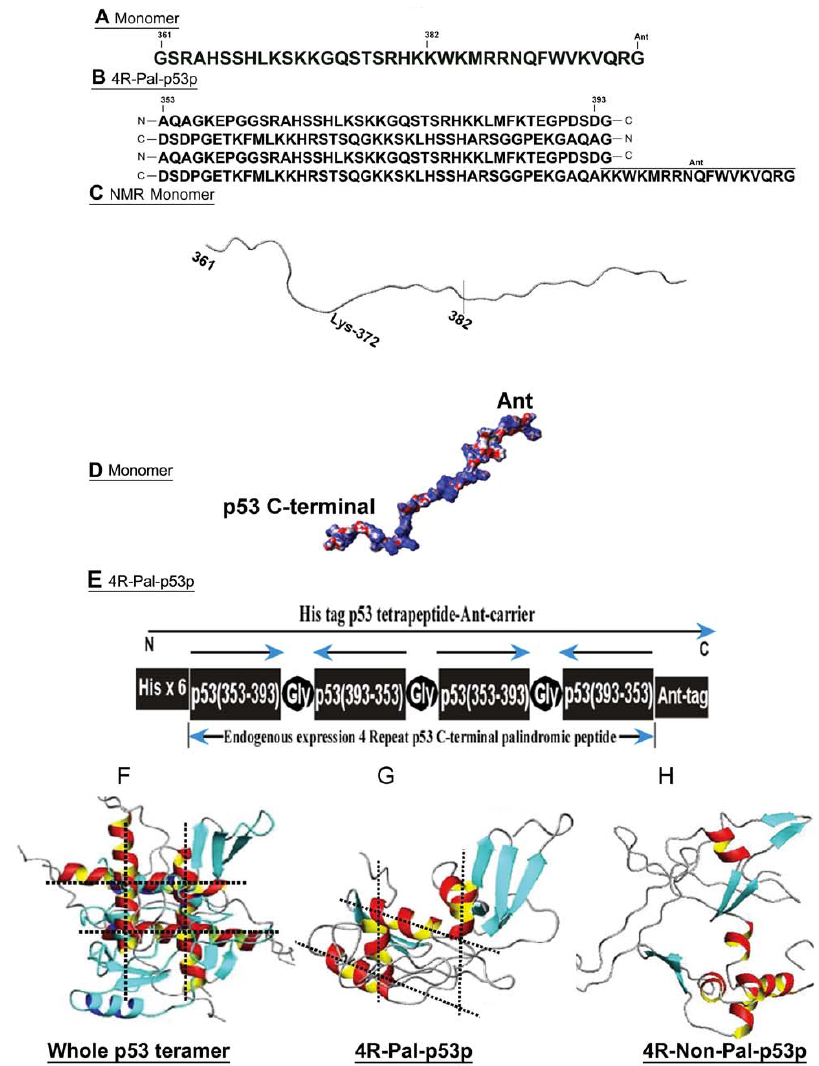
Figure 1. Proton-NMR derived structure of the monomeric p53p, and predicted structure of C- terminal p53 tetrapeptides. ( A ) The aa sequence structure of p53-Ant monomer. ( B ) The aa sequence structure of the 4 repeat palindromic tetrapeptide. ( C ) The ionic surface area of the p53-Ant monomer peptide. ( D ) Space filling model showing amphipathic structure formation. Blue (positive), grey (neutral), and red (negative). ( E ) The order and arrangement of the palindromic tetrapeptide. The tetrapeptide was expressed endogenously via stable transfection with plasmid or transient transfec- tion with Ad 5 vector without 6His and Ant. The 4R-Pal-p53p with 6His and Ant was synthesized and purified for exogenous exposures. ( F ) The whole p53 tetramer structure. ( G ) The predicted structure of the 4R-Pal-p53p endogenously expressed protein without Ant. ( H ) The predicted structure of the non-palindromic 4R-NonPal-p53p